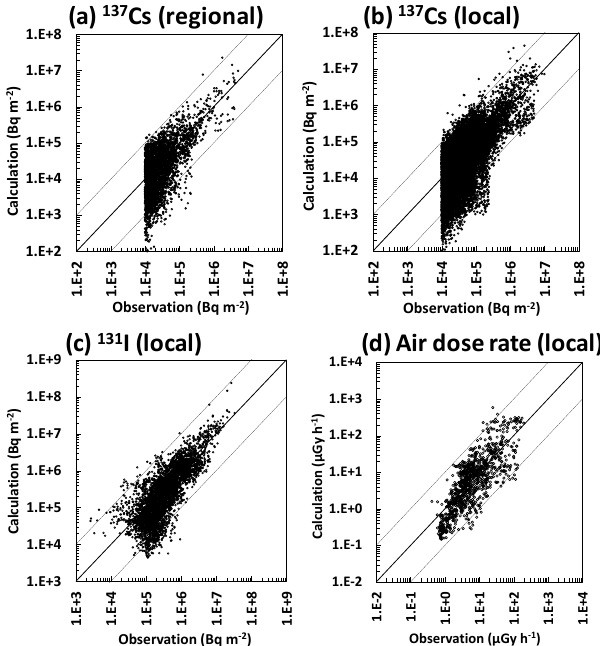
Figure 16. Scatter diagrams of the surface deposition of (a– b) 137 Cs and (c) total 131 I (Bqm − 2 ) on 1 April 2011 and of (d) the total air dose rate (µGyh − 1 ) on 18 March 2011 comparing the measurements (US DOE/NNSA, 2011; NRA, 2012a; Torii et al., 2013) and calculations using the modified WSPEEDI-II with the new source term for (a) Domain 2 and (b–d) Domain 3. The black solid lines show 1:1 correspondence, and the bands within a fac- tor of 10. The region for the air dose rate comparison is depicted in Fig.